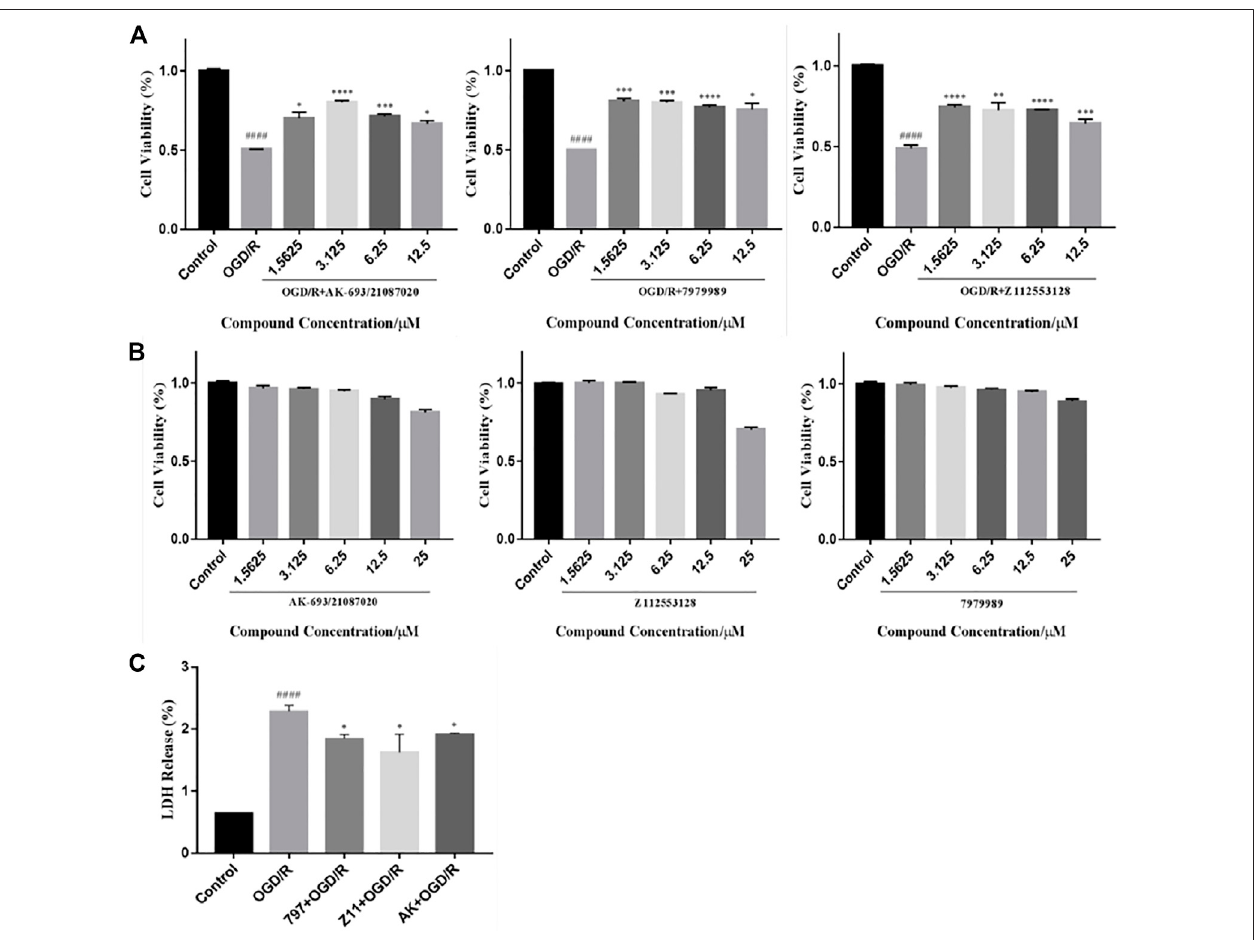
FIGURE 4 | Compounds inhibit OGD/R-induced cell viability loss and cell apoptosis. (A) MTT assay showed that the candidate compounds (12.5 – 1.5625 μ M) were safe for PC12 cells. Values obtained from three independent experiments are expressed as mean ± SD (% of control). (B) Protective potential of the candidate compound (12.5 – 1.5625 μ M) on cell viability of PC12 cells exposed to OGD/R. (C) LDH release after OGD/R injury. Each bar represents the mean ± standard deviation (SD) calculated from three independent experiments. #### p < 0.0001 vs. control group; **** p < 0.0001; *** p < 0.005, ** p < 0.01, * p < 0.05 vs. OGD/R